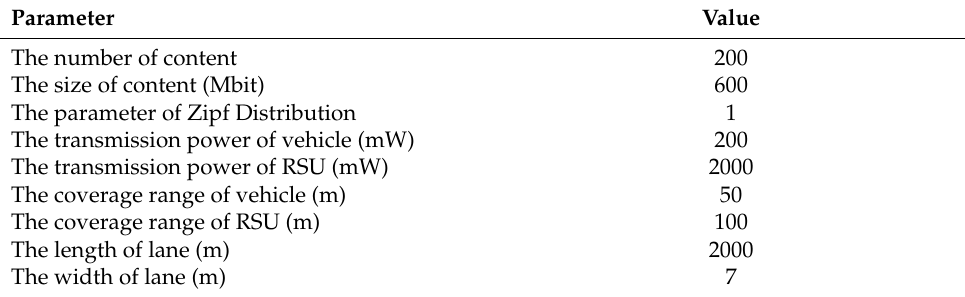
Table 2. Simulation